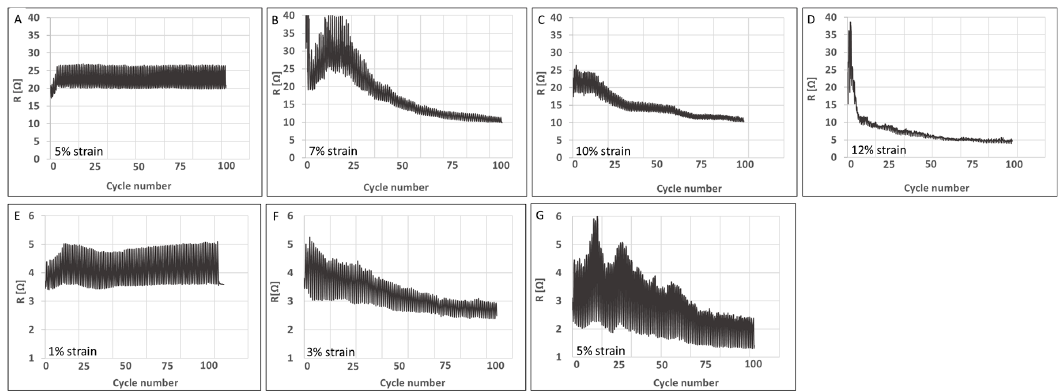
Figure 6. Electrical properties of untreated CNTYs ( A – D ) and post ‐ treated CNTYs ( E – G ) during cyclic stretching to a different loading strain (100 cycles).